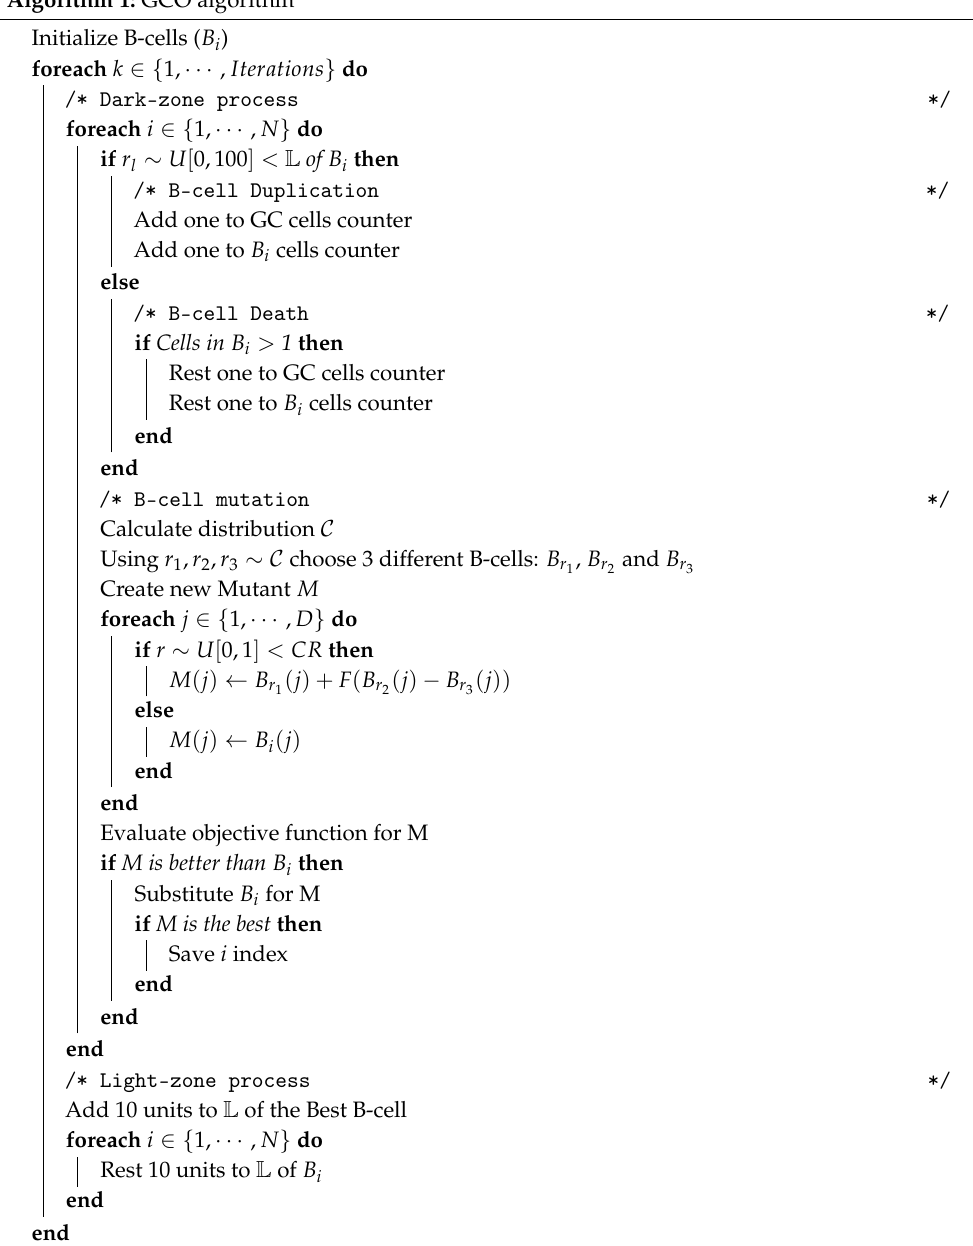
Algorithm 1: GCO